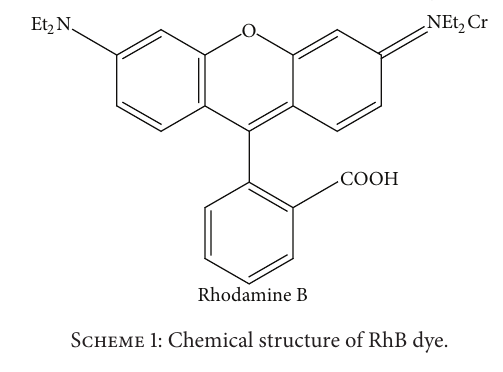
Scheme 1: Chemical structure of RhB dye.